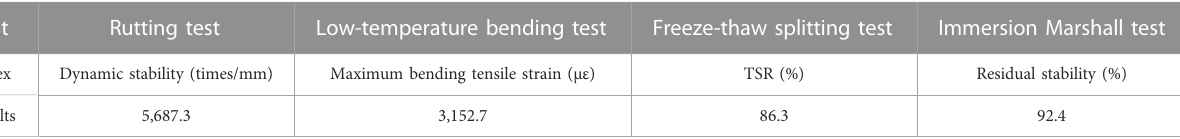
TABLE 19 Pavement performance for gradation